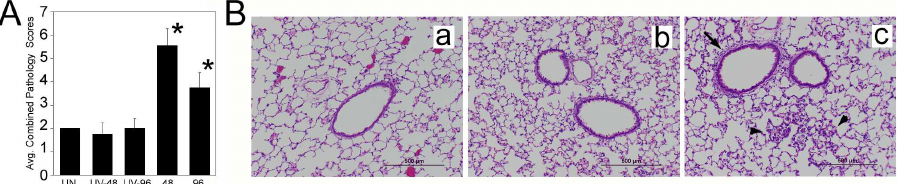
Fig 3. VANBT infection in cotton rats causes lung pathology. (A) Histopathology scores obtained from lungs of uninfected(UN) or UV-VANBT or VANBT infected animals and euthanizedat the indicatedtime p.i. Combinedscores represent extent of peribronchiolitis, perivasculitis, interstitial inflammation and alveolitis. n = 4–8, * p < 0.05 for VANBT compared to UV-VANBT at respective time point. (B) Representative H&E- stained lung sections in na ï ve rats (a) or lungs taken after 48 h after i.n. inoculationwith UV-VANBT (b), or VANBT (c). Peribronchial inflammation (black arrow) and alveolitis(black arrow head) are indicated. Scale bars, 500 μ m. Images shown are representative of four cotton